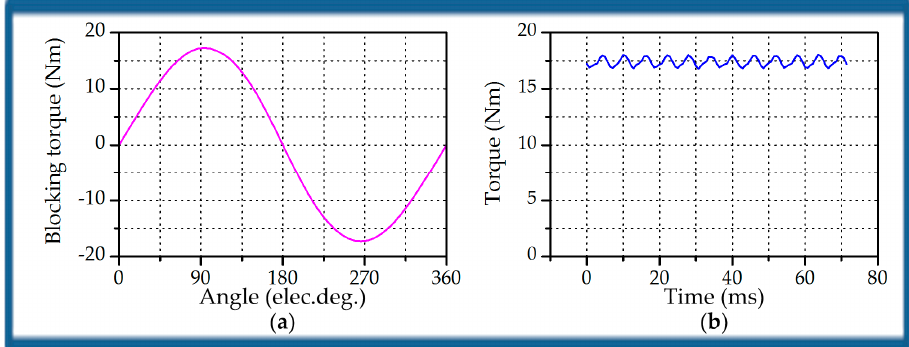
Figure 12. Proposed DPME machine with I = 3 A: ( a ) Blocking torque; and, ( b ) Maximum torque.